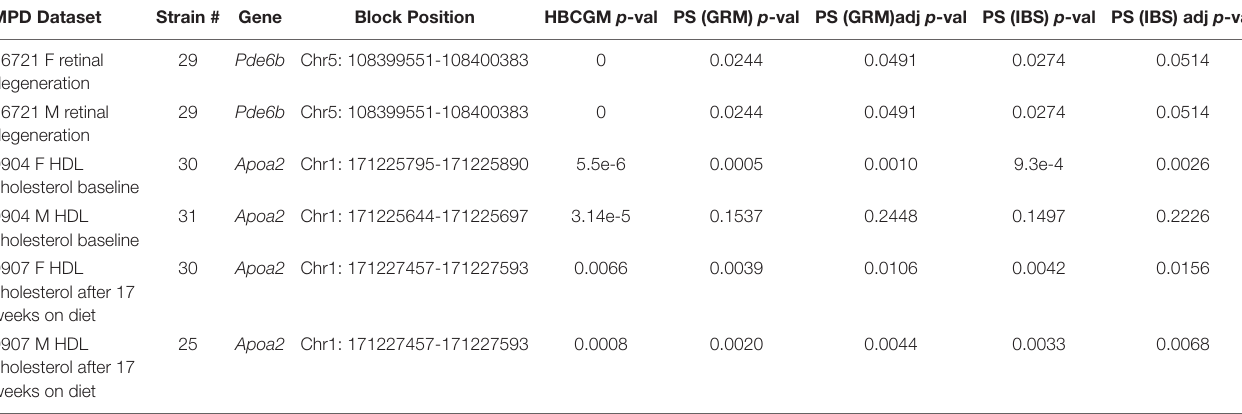
TABLE 2 | The results of PS analysis performed on haplotype blocks within known causative genes for 3 MPD datasets (each with data from both sexes) are shown. MPD Dataset